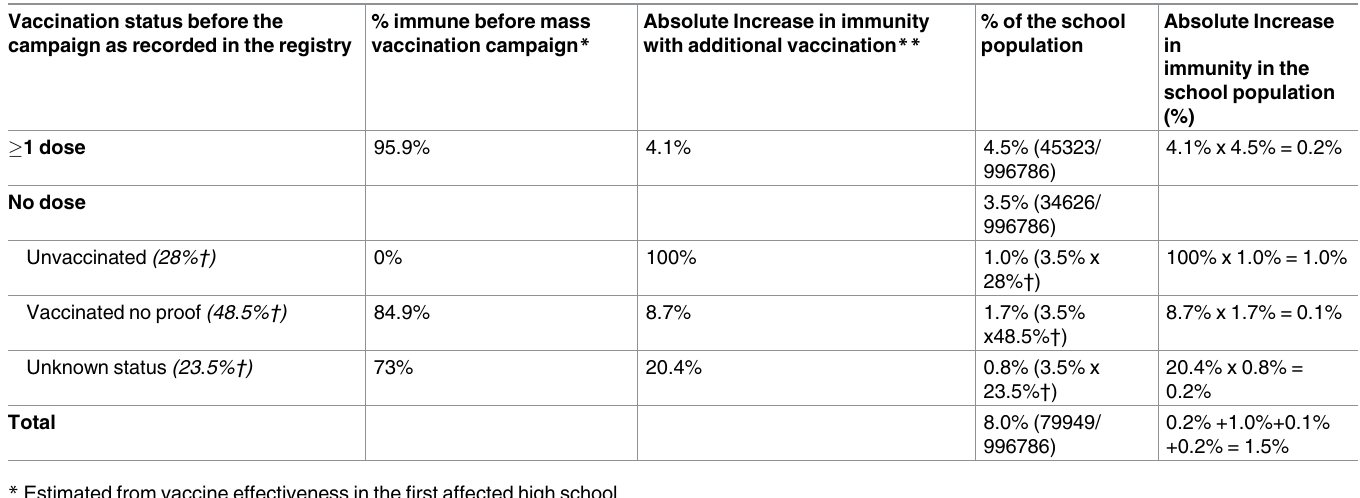
Table 4. Absolute increasein the school population immunity following the masscampaign by vaccination status before the campaign. Vaccination status before the % immune before mass Absolute Increase in immunity campaign as recorded in the registry vaccination campaign * with additional vaccination